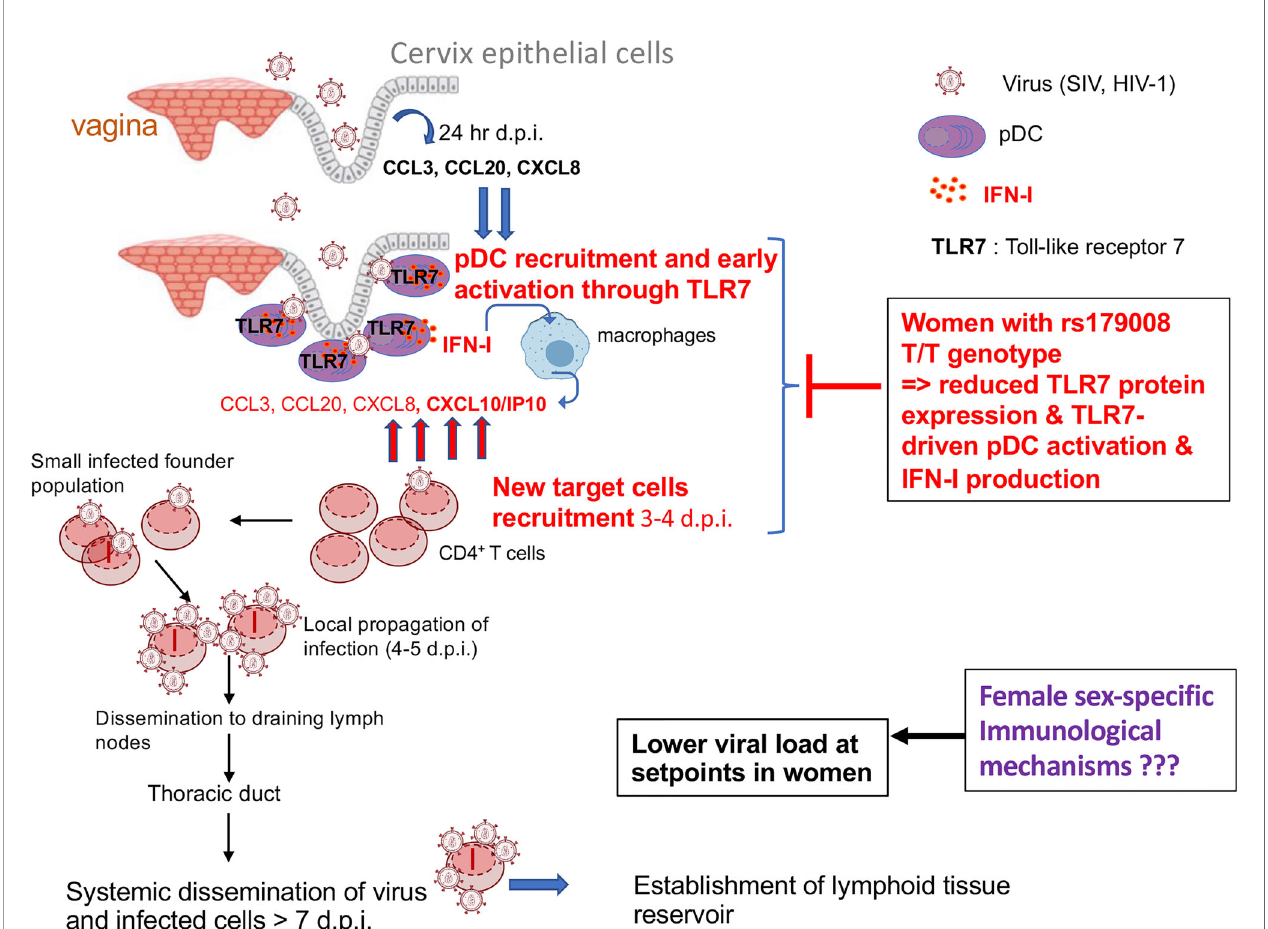
FIGURE 2 | Model of infection and dissemination of HIV-1. Cervical epithelium in the female reproductive tract responds through unknown mechanisms to exposure to the SIV inoculum by producing CCL3, CCL20, and CXCL8. pDCs are the fi rst innate cells to be recruited by day 1-3 post-infection by epithelial-derived chemokines [and other innate cells such as macrophages at later time points (48)], which can be activated by viral particles which can penetrate the mucosal barriers. IFN-I released by pDCs can induce IP-10/CXCL10 production by macrophages and TLR7-activated pDCs themselves produce CCL3, CCL5, and IP-10/ CXCL10 to create a focal chemokine gradient beneath the epithelium which recruits CCR5 expressing CD4 + T cells to establish productive infection, creating a feed forward loop to sustain pDCs recruitment and further increases in CD4 T-cell targets (47,